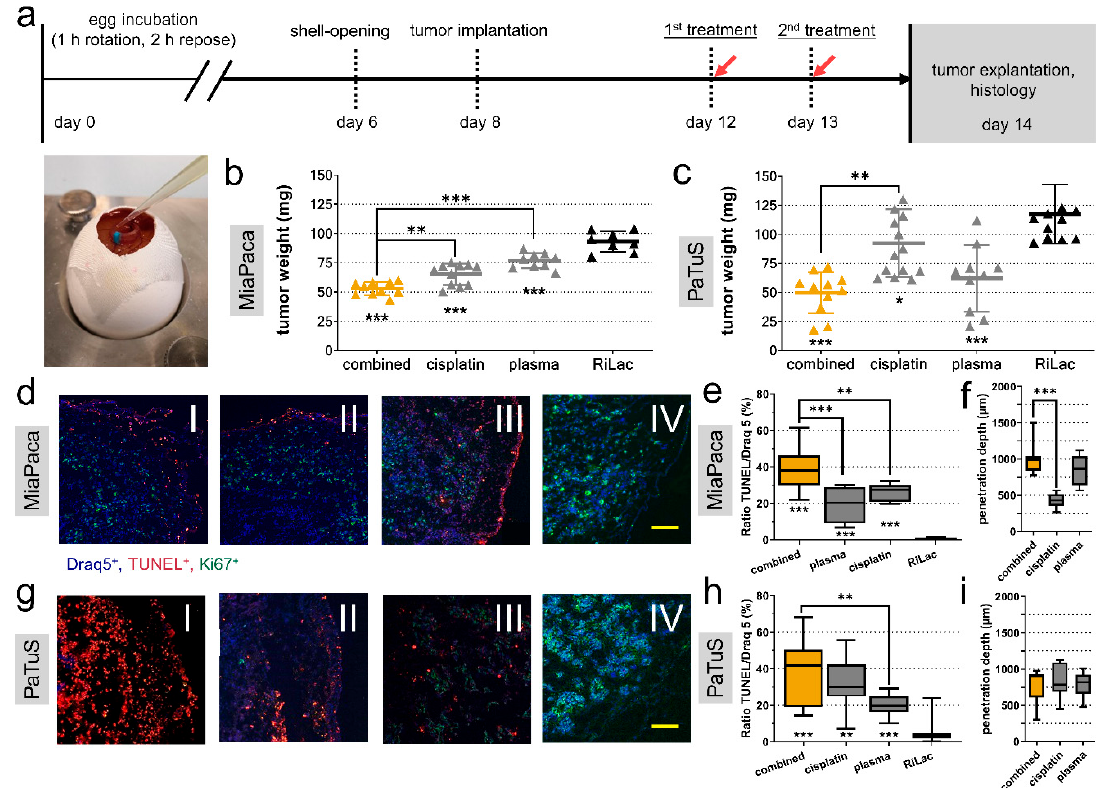
Figure 7. The combination of cisplatin with physical plasma-conditioned Ringer’s lactate showed additive toxicity in three-dimensional tumors grown on chicken embryos. ( a ) Schematic overview of in ovo experiments and image of treatment with liquids of three-dimensional pancreatic tumors grown on the chorion-allantois membrane of fertilized chicken eggs (TUM-CAM); ( b , c ) tumor weight quantified at 48 h post-treatment with Ringer’s lactate (RiLac), plasma-conditioned RiLac, cisplatin, or the combination of physical plasma-conditioned RiLac and cisplatin in MiaPaca ( b ) and PaTuS ( c ) tumors; ( d , g ) representative images of apoptotic MiaPaca ( d ) and PaTuS ( g ) cells (blue = Draq5 + , red = TUNEL + , green = Ki67 + ; scale-bar = 100 µ m) in cryo-sections of the tumors exposed to the combination treatment (I), cisplatin (II), plasma-RiLac (III) and RiLac alone (IV); ( e , h ) algorithm-based quantitative image analysis of the percentage of apoptotic cells (TUNEL + / Draq5 + ) in MiaPaca ( e ) and PaTuS ( h ) tumors; ( f , i ) penetration depth of the treatment regimen in MiaPaca ( f ) and PaTuS ( i ) tumors. Data are representative from two independent experiments with eight to thirteen eggs per group and show ( b , c ) individual values with their mean ± SD, and ( e , f , h , i ) median and min to max. Statistical significance was calculated utilizing ANOVA.